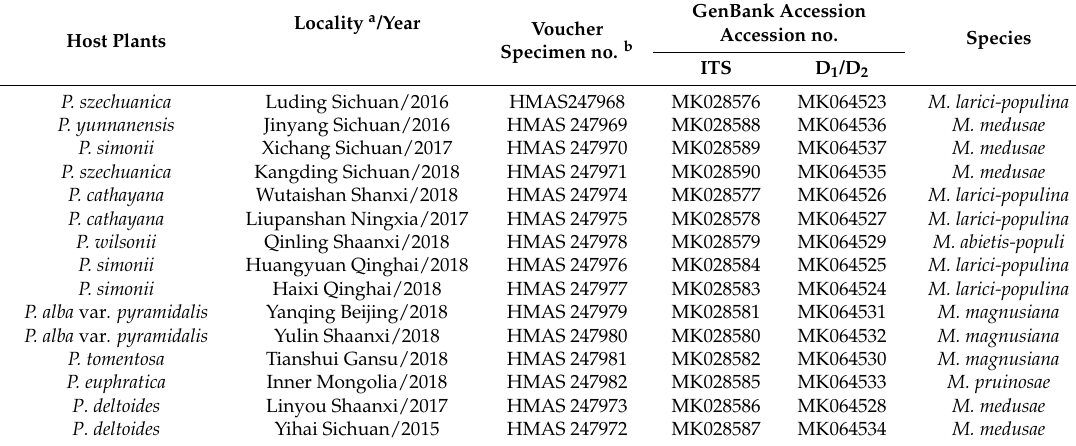
Table 1. Fifteen fully characterized samples of Melampsora in China identified as species, with host plants, sampling locations, years, and voucher and GenBank accession numbers. The two samples of rust on P. deltoides are both from cv. ‘Zhonghua